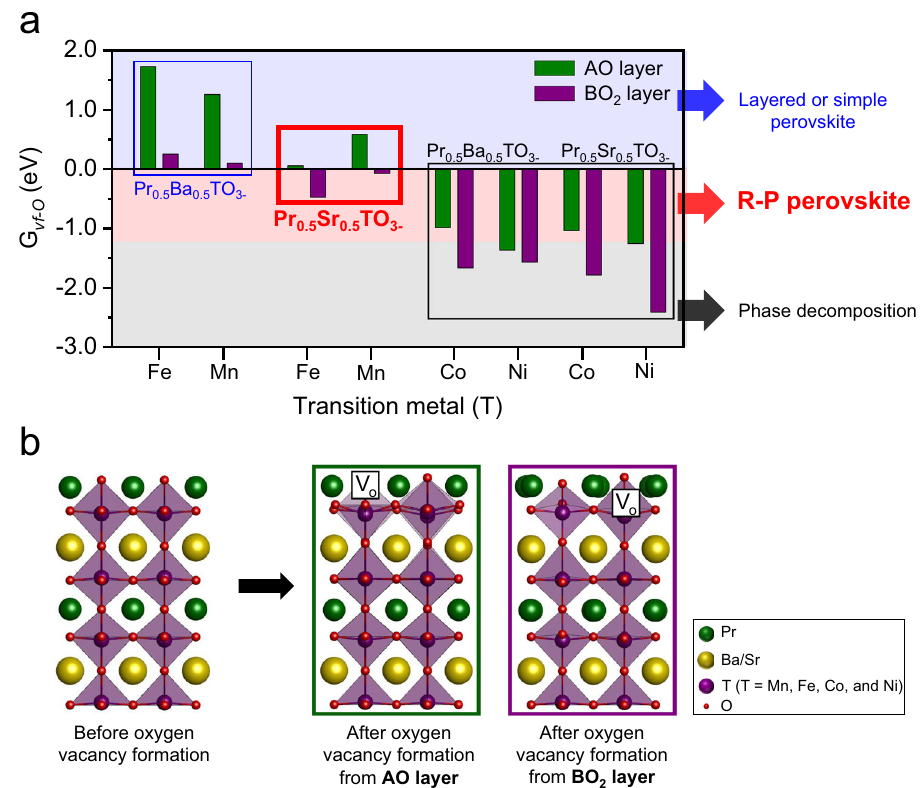
Fig. 1 Density functional theory calculations. a Calculated Gibbs free energy for oxygen vacancy formation (G vf-O ) of Pr 0.5 (Ba/Sr) 0.5 TO 3 − δ (T = Mn, Fe, Co, and Ni) from the surface AO (green bar) and BO 2 (purple bar) networks and the predicted phase change under reducing condition. b Schematic illustration of the most stable structure con fi gurations of Pr 0.5 (Ba/Sr) 0.5 TO 3 − δ (T = Mn, Fe, Co, and Ni) slab models used for the calculations of oxygen vacancy formation energy values from AO and BO 2